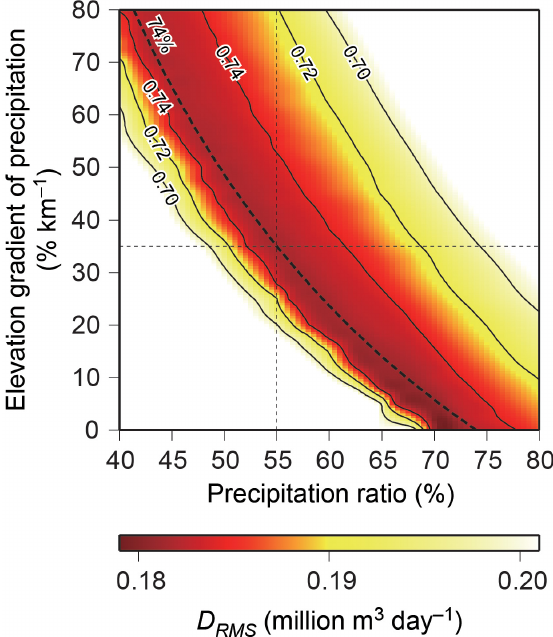
Figure 7. Root mean square difference ( D RMS , colour shading) and Nash–Sutcliffe model efficiency coefficient ( E N , contour lines) of the model performance for the Tsho Rolpa Glacial Lake–Trambau Glacier basin calculated for the period 1993–1996 (location shown as yellow cross in Fig. 1a), as a function of precipitation ratio (hor- izontal axis) against the original Aphrodite precipitation and ele- vation gradient of precipitation (vertical axis). We adopt 55% as the precipitation ratio and 35%km − 1 as the elevation gradient of precipitation for subsequent analysis (thin dashed lines). The thick dashed line denotes the 74% precipitation ratio isoline for the whole